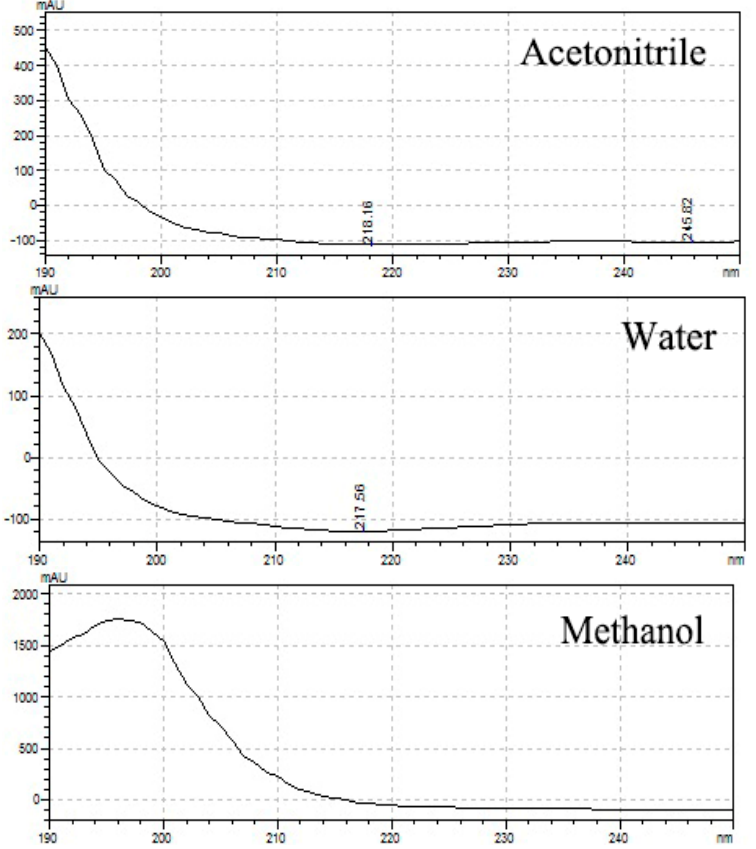
Figure 3. Absorbance spectrum of HPLC mobile phase; acetonitrile, methanol, and HPLC water. Analysis was carried out from 190 nm, the lowest detection wavelength of the instrument.